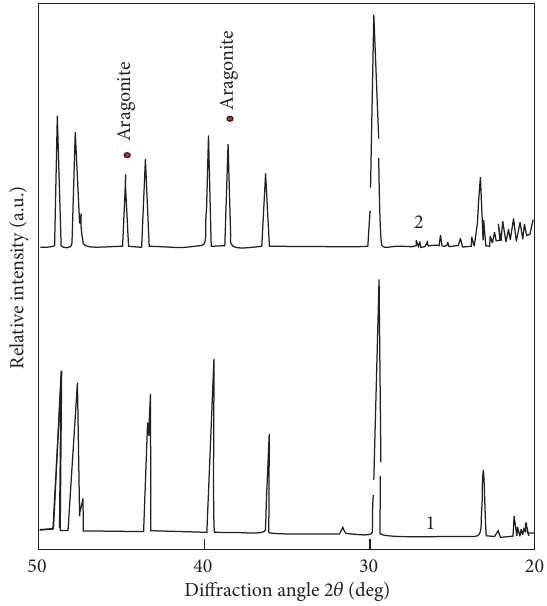
F 1: X-ray diffraction patterns of in situ generated CaCO from calcium oxalate monohydrate—1 and CaCO